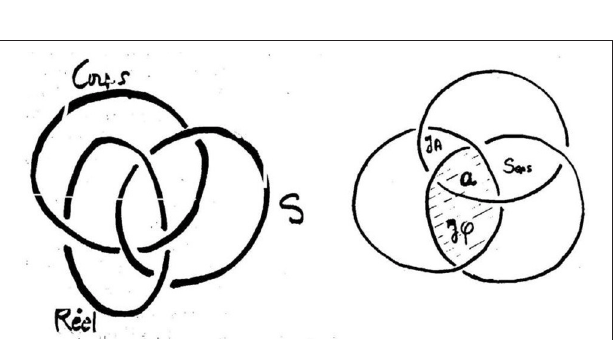
FIGURE 5 | The Borromean knot, J. Lacan, conference “ La troisième .”